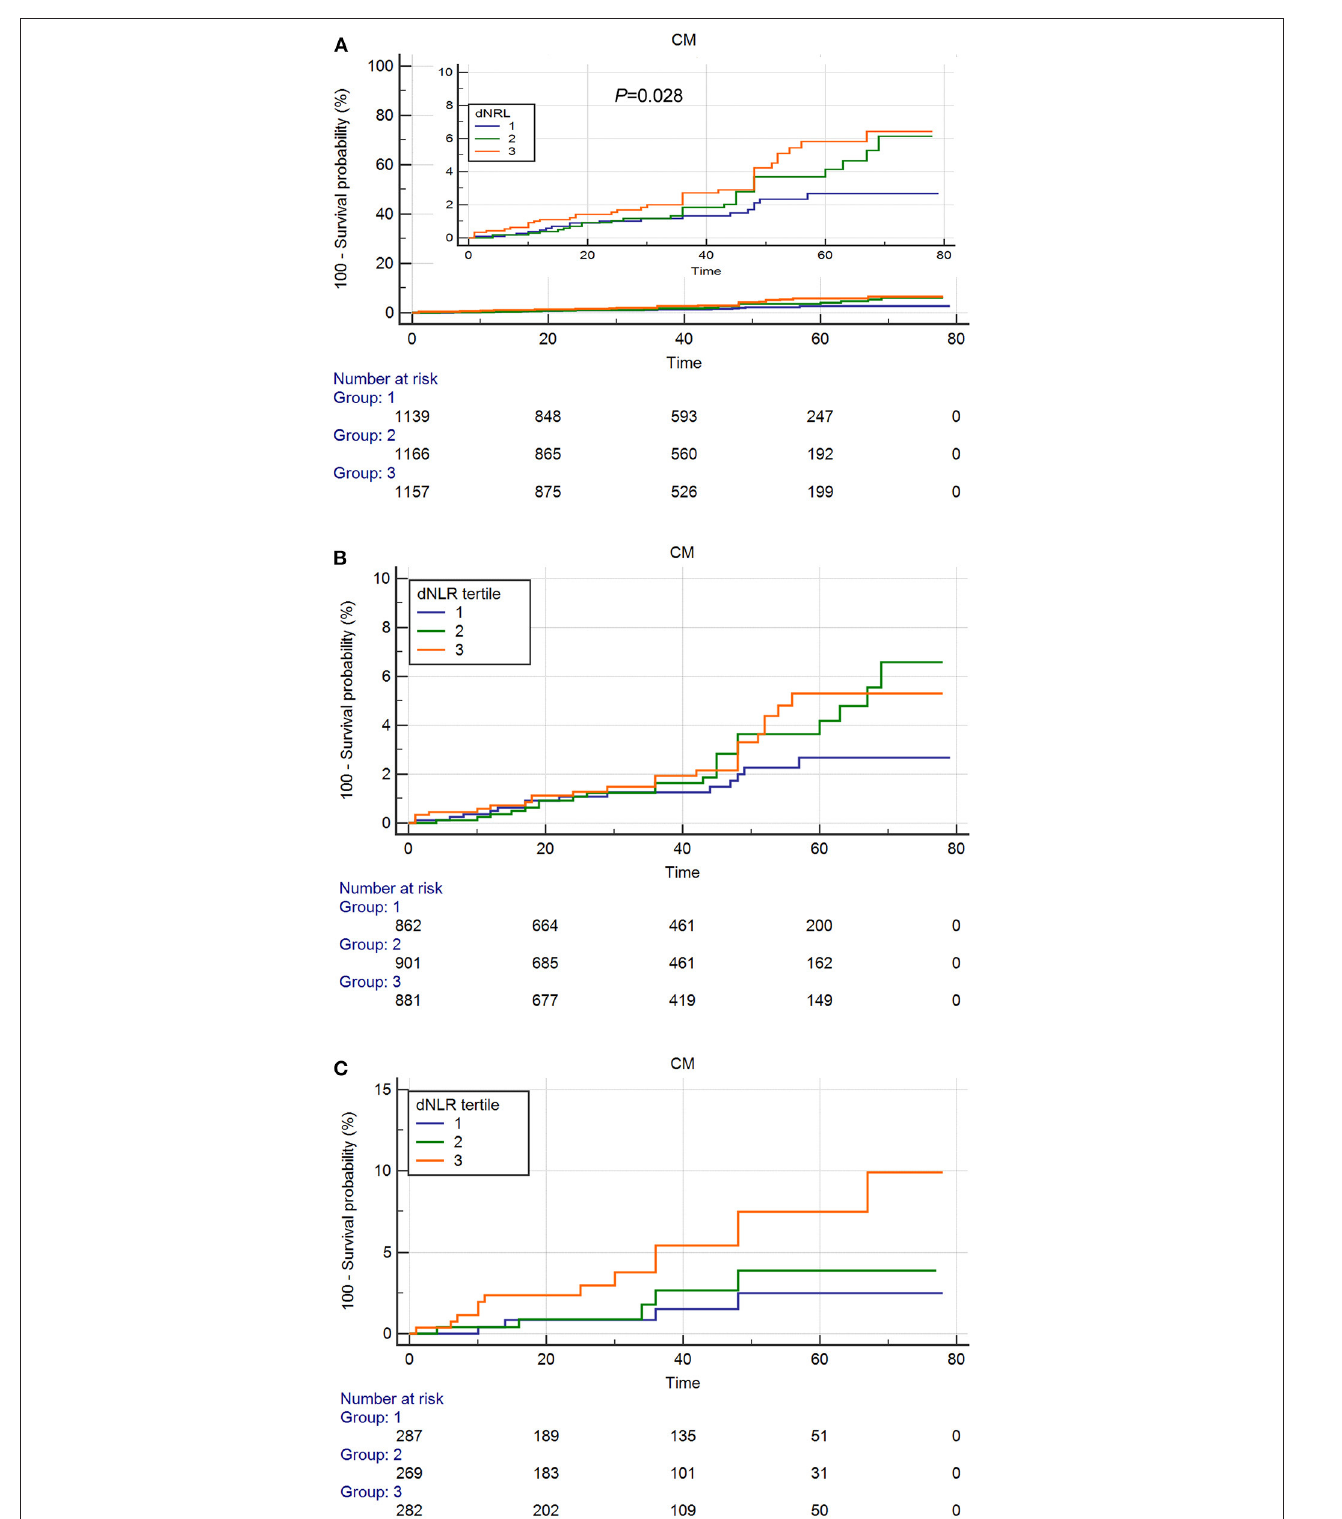
FIGURE 3 | Cumulative Kaplan–Meier estimates of the time to the first adjudicated occurrence of cardiac death. (A) Total Patients. (B) ACS patients. (C) CCS patients.